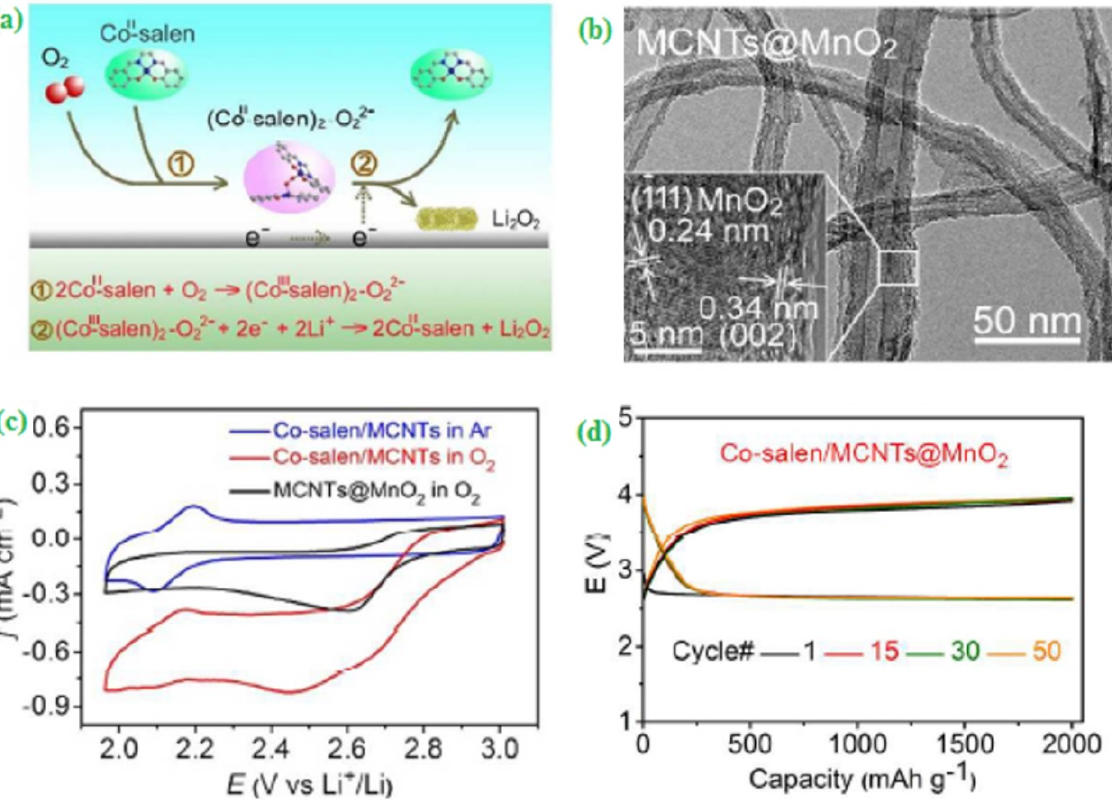
Figure 2. Synthesis and analysis of Co–salen/MCNTs@MnO 2 ( a ) Schematic illustration for the reaction mechanism of the LABs with Co II –salen in the electrolyte during discharge and charge process, ( b ) TEM images of MCNTs@MnO 2, ( c ) Cyclic voltammograms obtained for ORR at a scan rate of 10 mV s –1 and ( d ) Discharge/charge profiles for Co–salen/MCNTs@MnO 2 at 500 mA g ‒ 1 with the cut-off capacity of 2000 mAh g –1 . Copyright 2017 by American Chemical Society [45].